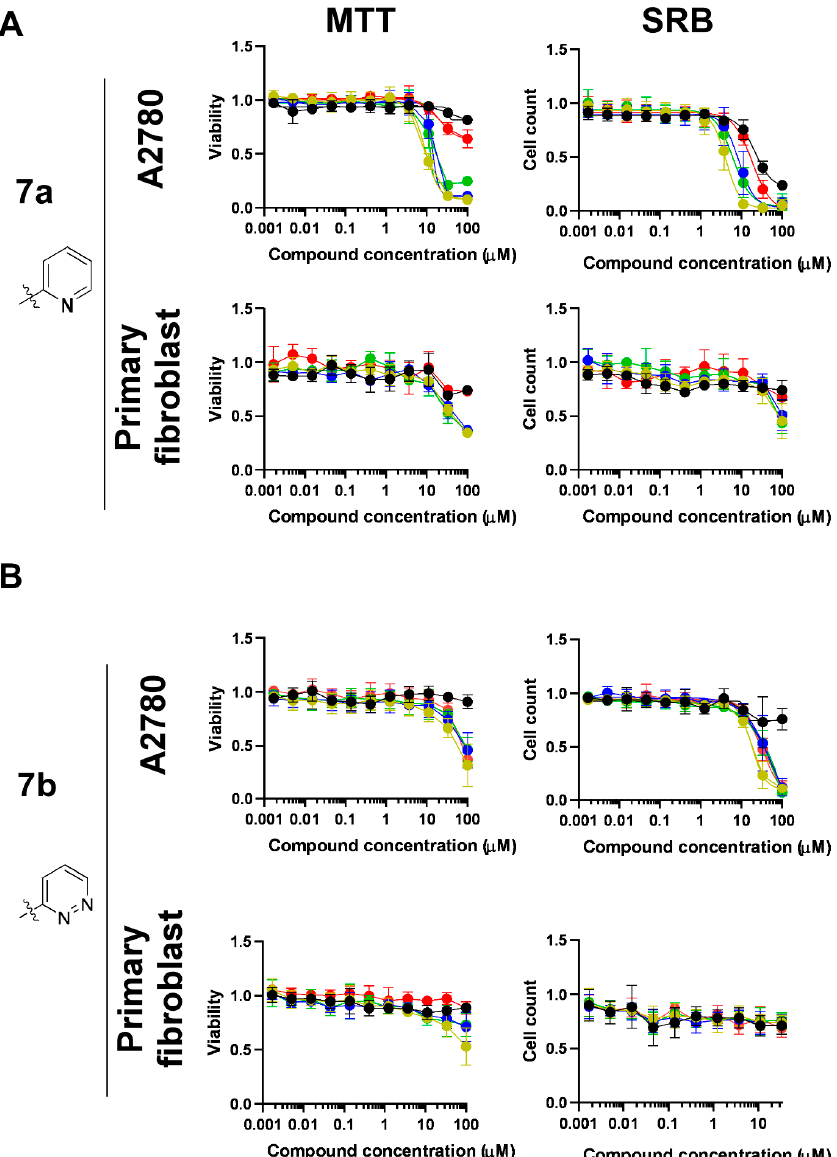
Figure 4. Assessment of free ligands 7a,b and their complexes ( Ru/Os/Ir/Rh-7a and Ru/Os/Ir/Rh-7b ) for cytotoxic and cytostatic activity (panel ( A ) for compound 7a and its complexes; panel ( B ) for compound 7b and its complexes). For MTT assays, 3 × 10 3 A2780 cells or 4 × 10 3 primary fibroblasts were plated in 96-well plates. For SRB assays, 1.5 × 10 3 A2780 cells or 2 × 10 3 primary fibroblasts were plated in 96-well plates. Cells were treated with the compounds in the concentrations indicated for either 4 h for the MTT assay or for 48 h for the SRB assay. Data are represented as average ± SD from three biological replicates; individual assays were performed in duplicate. Values were normalized for vehicle-treated cells; absorbance for vehicle-treated cells equals 1. Statistical significance was assessed using a one-way ANOVA test comparing all values to the lowest concentration of a compound. Before the test, normality was assessed using the Shapiro–Wilk test, and the post hoc test was chosen accordingly. For better visibility, the p values and distributions are presented in an Excel sheet available at https://figshare.com/s/9ec2a005e6b9e5874c07. Nonlinear regression was performed on the datasets indicated in Table 6. Color code: black—free ligand ( 7a or 7b ), khaki—ruthenium complex ( Ru-7a or Ru-7b ), blue—osmium complex ( Os-7a or Os-7b ), green—iridium complex ( Ir-7a or Ir-7b ), red—rhodium complex ( Rh-7a or Rh-7b ).